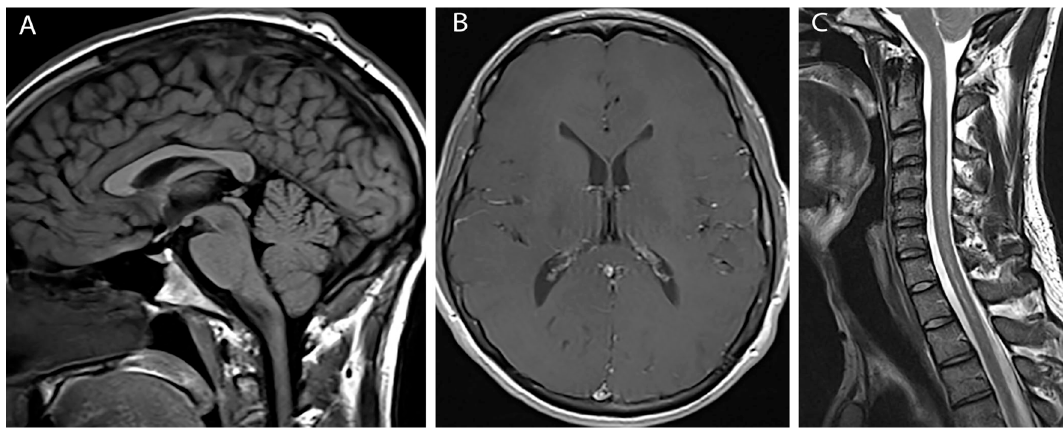
Figure 3. Post-treatment images ( A ) Sagittal T1 weighted image shows resolution of tonsillar herniation; ( B ) Axial post gadolinium image shows resolution of pachymengeal enhancement; ( C ) Sagittal T2 weighted image shows resolution of cord edema and syrinx.